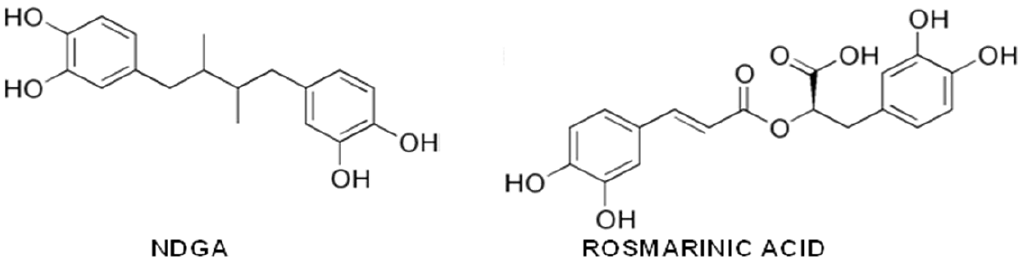
Figure 7. Nordihydroguaiaretic acid (NDGA) and rosmarinic acid